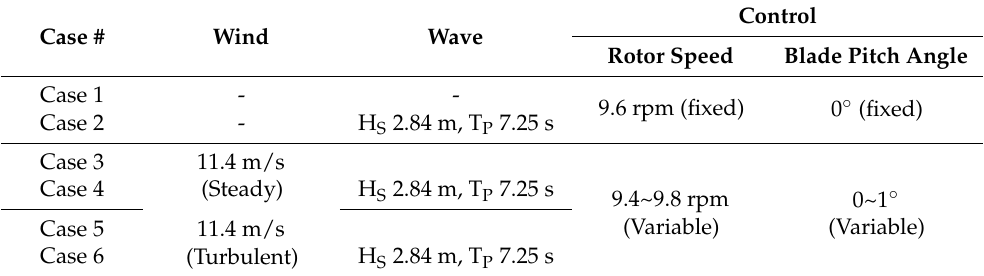
Control Rotor Speed Blade Pitch Angle